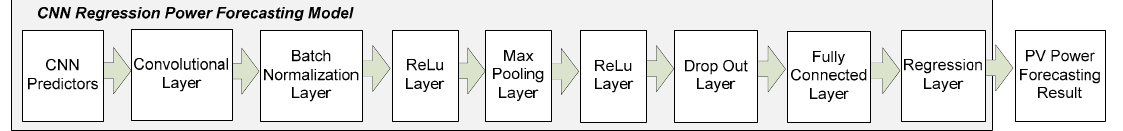
Figure 6. CNN regression for the short-term PV power forecasting.